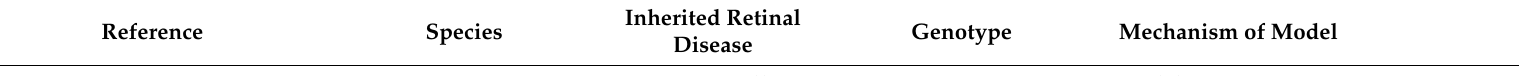
Table 1. Summary of non-human primate models of inherited retinal